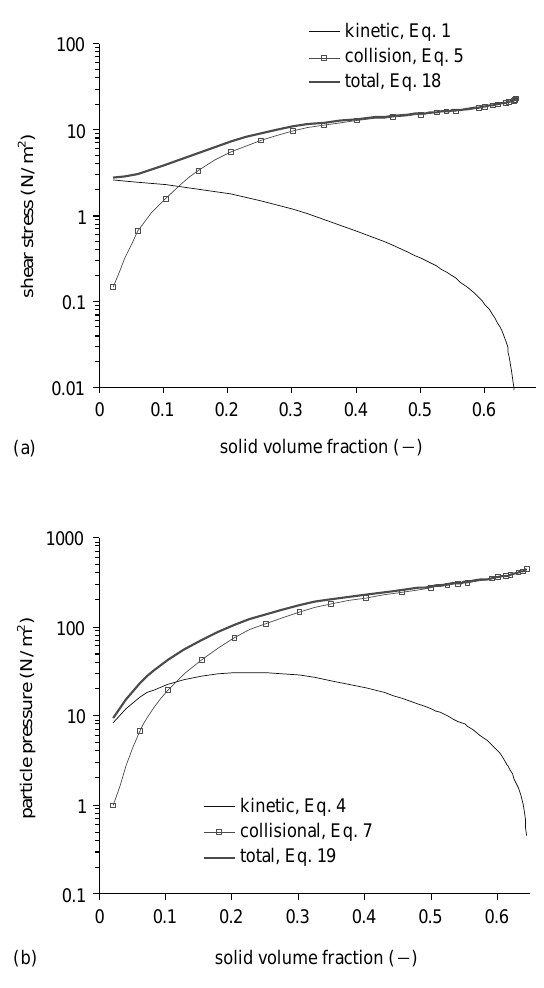
Classic kinetic stresses as a function of particle concentra- tion (a), shear stresses (b) solid